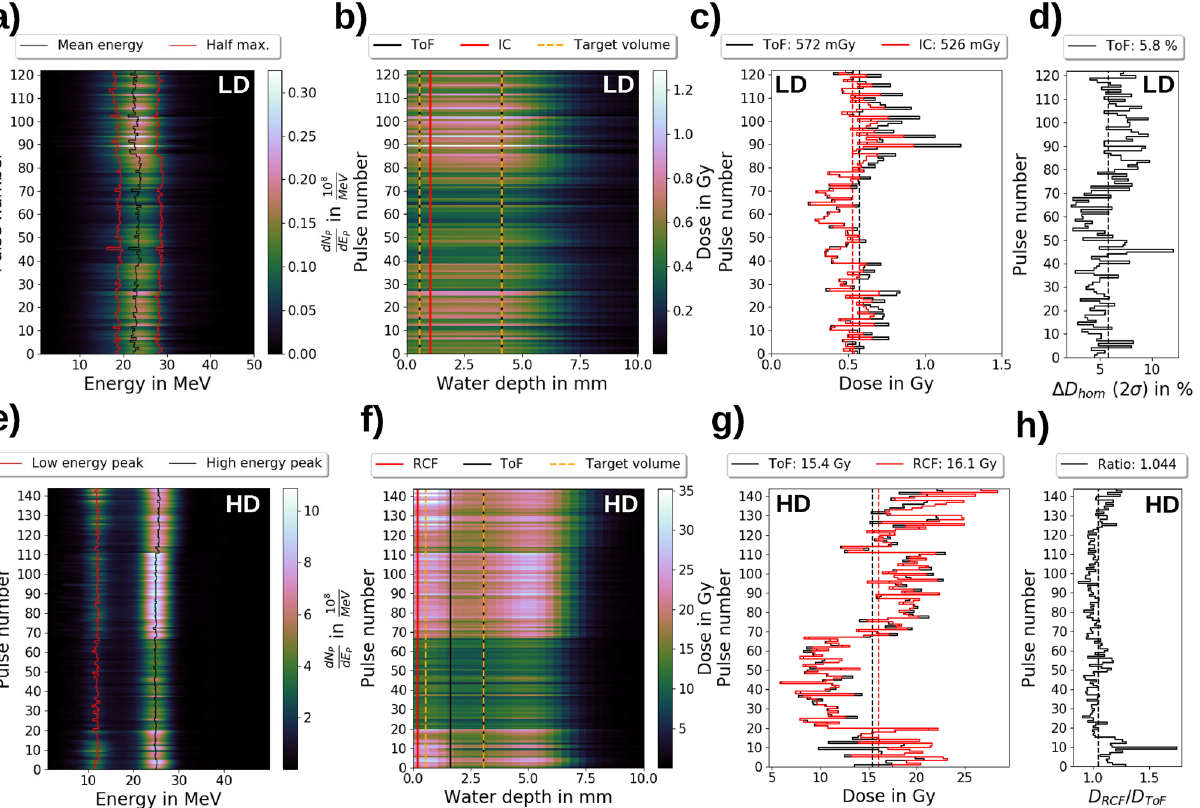
Figure 5. The time-of-flight (ToF) beam monitoring system (BMS) data of the transported kinetic proton energy spectra and predicted depth dose distributions at the irradiation site for the low dose per pulse (LD) and high dose per pulse (HD) operation mode. ( a ) The kinetic proton energy spectra of the LD operation mode with the mean energies and the half maximum positions. ( b ) The predicted depth dose distibutions of the LD operation in the target volume, the position of the ionization chamber (IC) dose prediction and the region for the ToF dose prediction. ( c ) The mean dose values in the ToF BMS prediction region and the dose values of the IC prediction for the LD operation mode together with the corresponding mean values. ( d ) The depth dose inhomogeneity values as the 2 σ standard deviations of the dose values in the ToF prediction region for the LD operation mode. ( e ) The kinetic proton energy spectra of the HD operation mode with the corresponding peak positions. ( f ) The predicted depth dose distributions of the HD operation mode with the target volume, the position of the radiochromic film (RCF) dose measurement and the region for the ToF dose prediction. ( g ) The mean dose values in the ToF prediction region and the measured dose values by the single RCFs for the HD operation mode together with the corresponding mean values. ( h ) The depth dose inhomogeneity as the ratios of the measured RCF dose values and the mean dose values in the ToF prediction